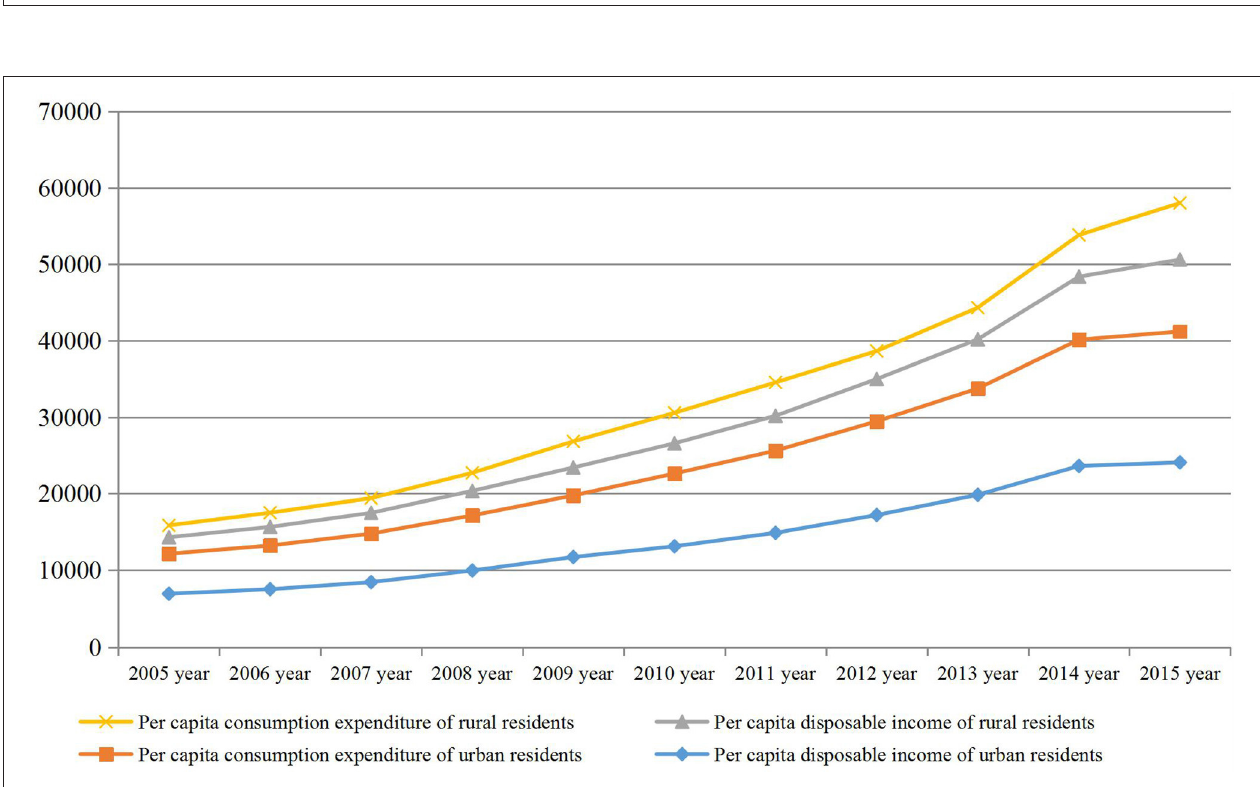
FIGURE 2 | Per capita disposable income and consumption of Wenzhou